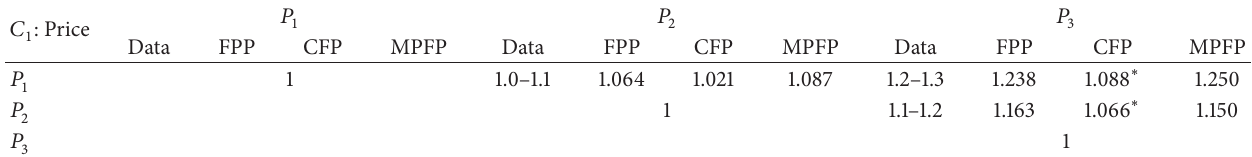
Table 5: Solution matrix of alternatives for 𝐶 1 (Example 1).